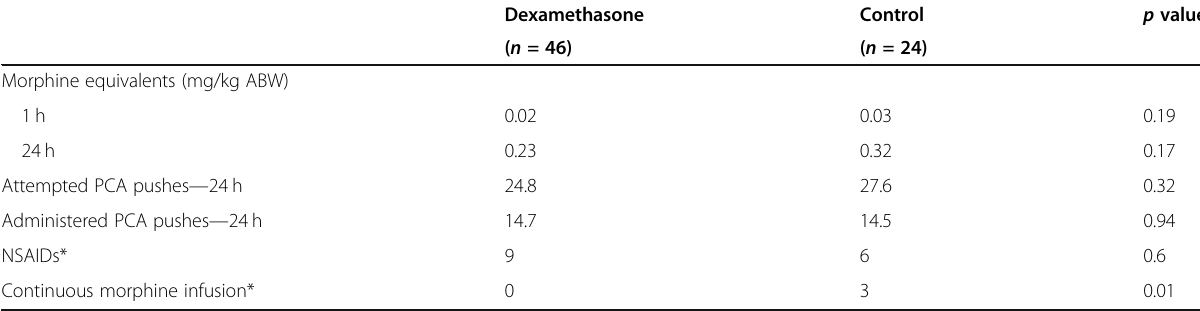
Table 3 Morphine consumption and rescue therapies